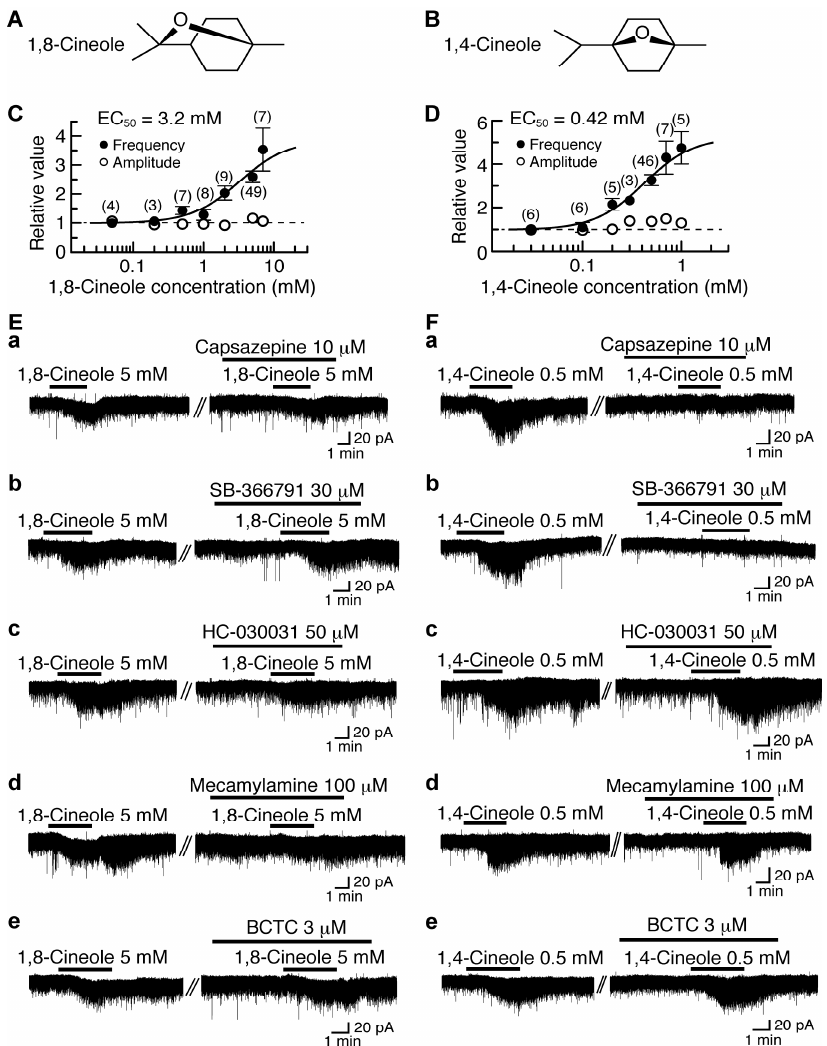
Figure 3. Effects of 1,8-cineole and 1,4-cineole on glutamatergic spontaneous excitatory transmission in rat SG neurons. ( A , B ) The chemical structures of 1,8-cineole ( A ) and 1,4-cineole ( B ). ( C , D ) The frequency and amplitude of sEPSC under the action of 1,8-cineole ( C ) or 1,4-cineole ( D ), relative to those before drug superfusion, which were plotted against the logarithm of drug concentration. This cineole effect was measured for 0.5 min around 3.5 min after the addition of its drug. The continuous curves in ( C ) and ( D ) were drawn according to the Hill equation (EC 50 and n H in ( C ) and ( D ): 3.2 mM, 1.3 and 0.42 mM, 1.7, respectively). ( Ea – e, Fa – e ) Chart recordings showing sEPSCs in the absence and presence of 1,8-cineole ( E ) or 1,4-cineole ( F ) in Krebs solution without (left) and with capsazepine ( a ), SB-366791 ( b ), HC-030031 ( c ), mecamylamine ( d ) or BCTC ( e ; right). In each of ( Ea – e, Fa – e ), the right recording was obtained about 20 min after the left one from the same neuron. V H = − 70 mV. This research was originally published in [27].